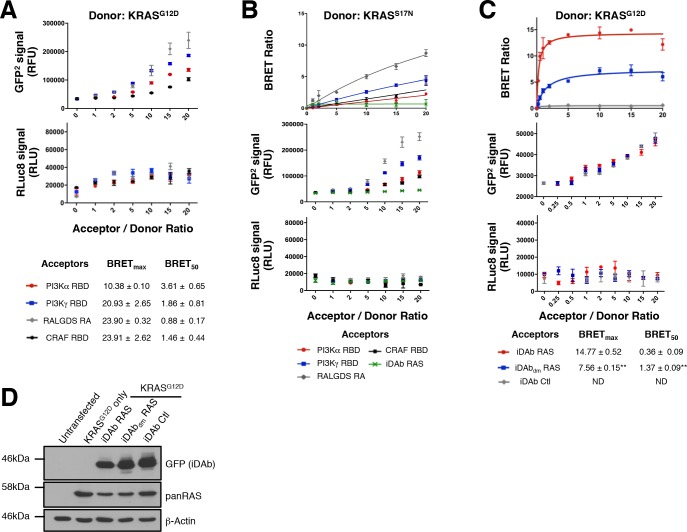
Validation of the RAS biosensors with the anti-iDAb RAS.(A) Total GFP2 and RLuc8 levels from the BRET titration curves in Figure 1B. (B) Representative BRET titration curves of KRASS17N and RAS binders (RBDs and iDAb RAS) with total GFP2 and RLuc8 controls. (C) BRET titration curves of KRASG12D and iDAbs with total GFP2 and RLuc8 controls. Statistical analyses were performed using an unpaired Student’s test (**p<0.01). (D) Western blots for assessment of the expression levels of each KRASG12D-iDAb BRET pair. Each experiment was repeated three times (A–C). Where error bars are presented, they correspond to mean values ± SD of biological repeats.